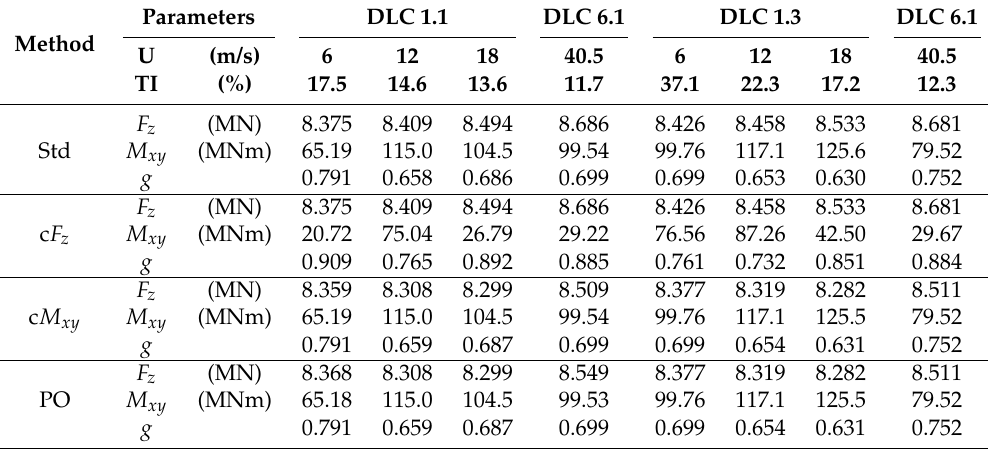
Table 2. Results for the OC3 monopile, for the mudline location. Both power production under standard conditions (DLC 1.1) and extreme turbulence (DLC 1.3), as well as idling under extreme wind speeds (DLC 6.1) were assessed. The latter was investigated for two different values of the turbulence intensity (TI). Std: standard approach using univariate maxima; c F z , c M xy : contemporaneous maxima for F z or M xy , respectively; PO: worst Pareto-optimal load vector. g : value of the limit state equation (Equation (5)).